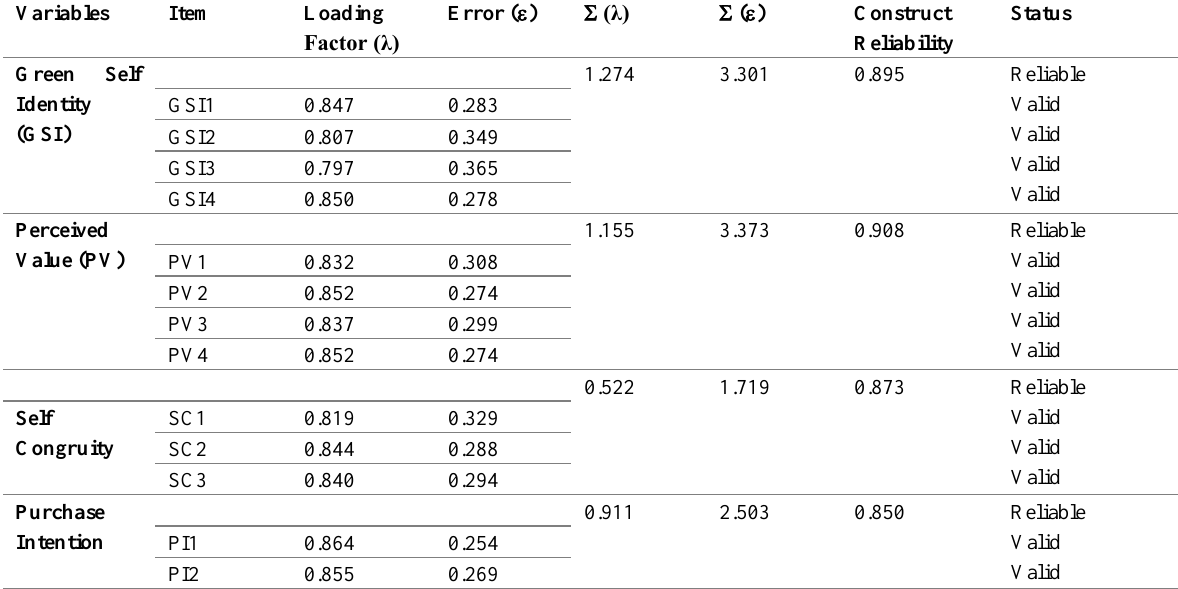
Table 2: Reliability and Validity of the Variables and Items